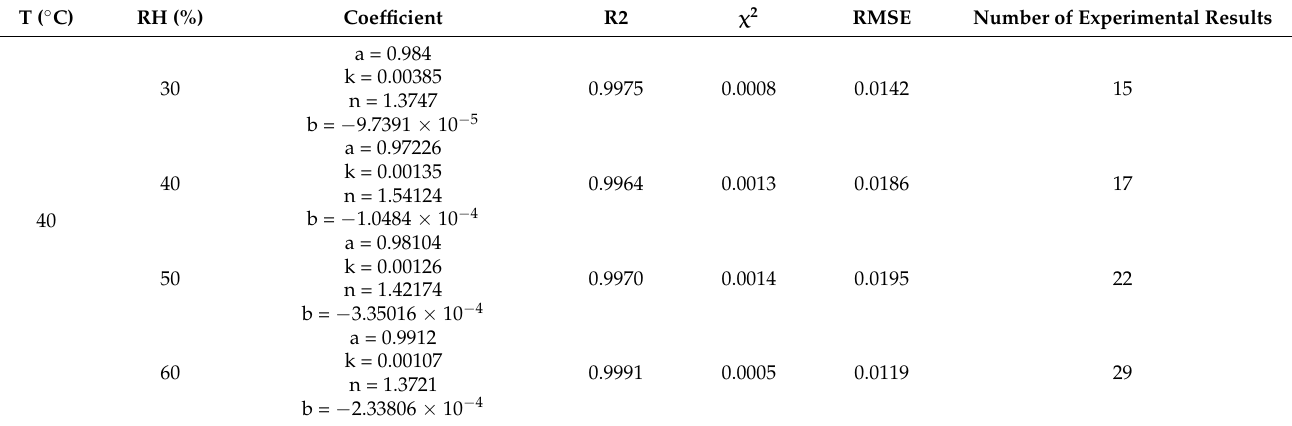
Table 3. Statistical analysis data of the Midilli model for sludge